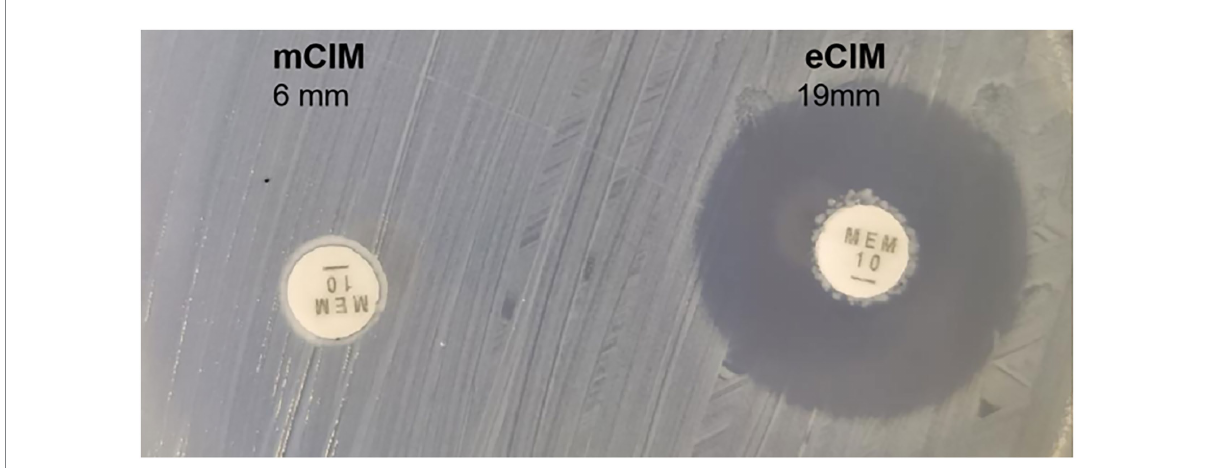
FIGURE 4 Meropenem discs of mCIM and eCIM tests of transformants. Notes:left: the inhibition zone diameter of mCIM was 6 mm; right: the inhibition zone diameter of eCIM was 19 mm.